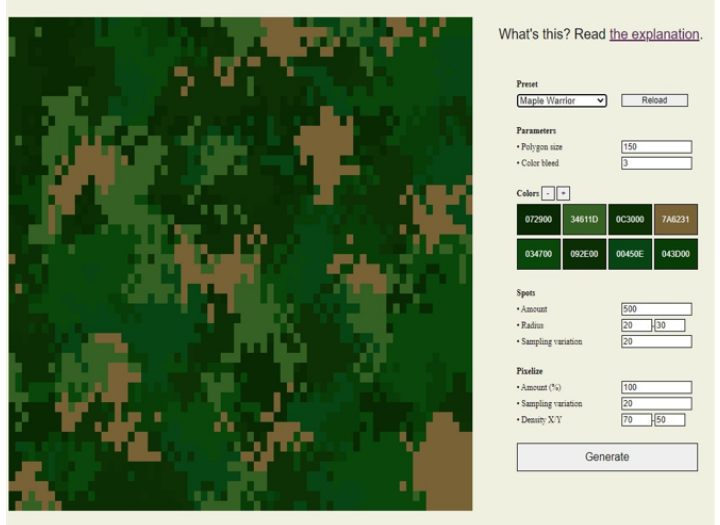
Figure 8. General view of Camouflage Generator